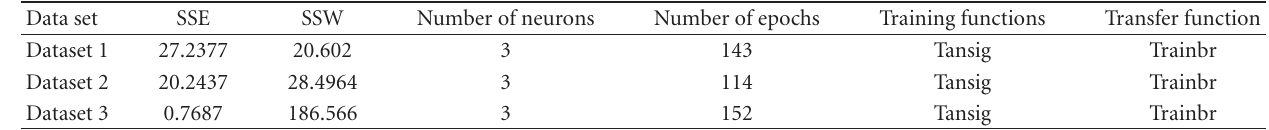
Table 4: Final architecture for all datasets.